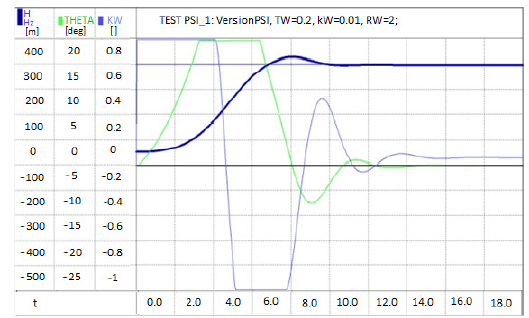
Figure 2. The transitional process of controlling flight alti tude ( H ) depending upon the value of the coefficient of control ( k w = 0.01), by making step changes to the given value from 50 metres to 400 metres, for the derivative constant of R w = 2 [s]